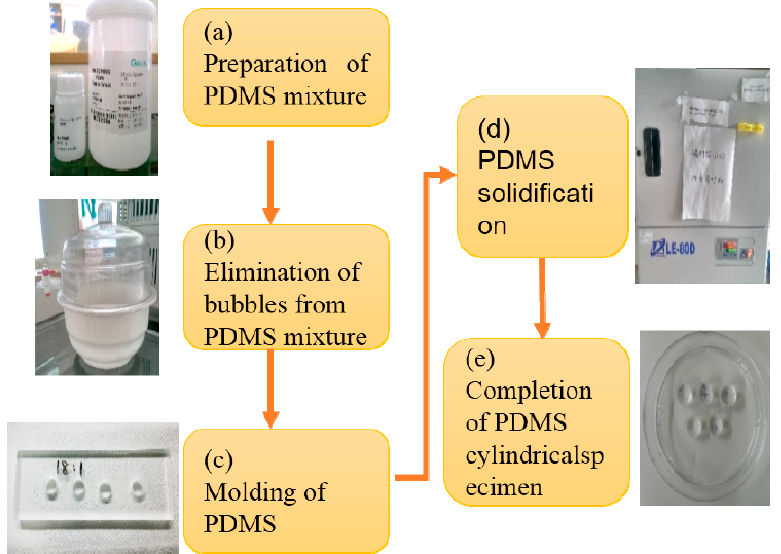
Figure 1. Production process of PDMS cylindrical specimen; ( a ) PDMS mixture was prepared by